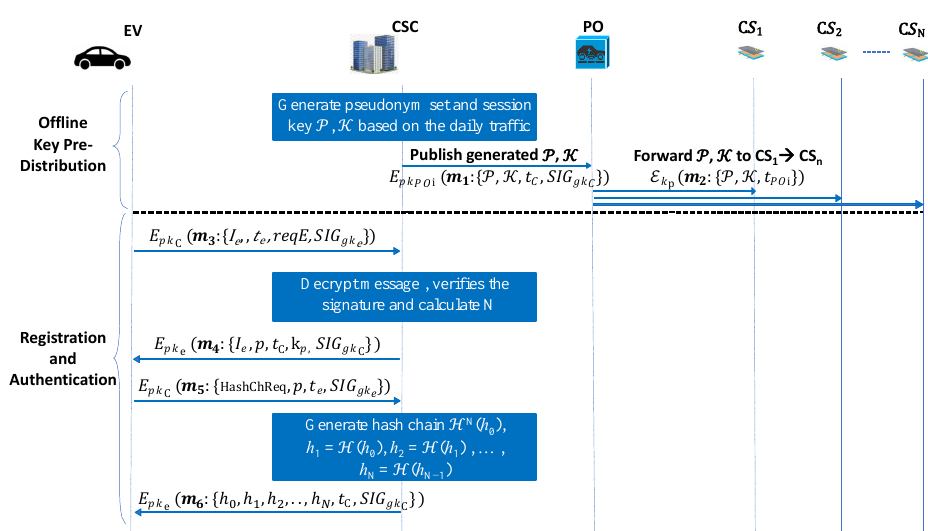
Figure 4. Message sequence for key pre-distribution, registration and authentication